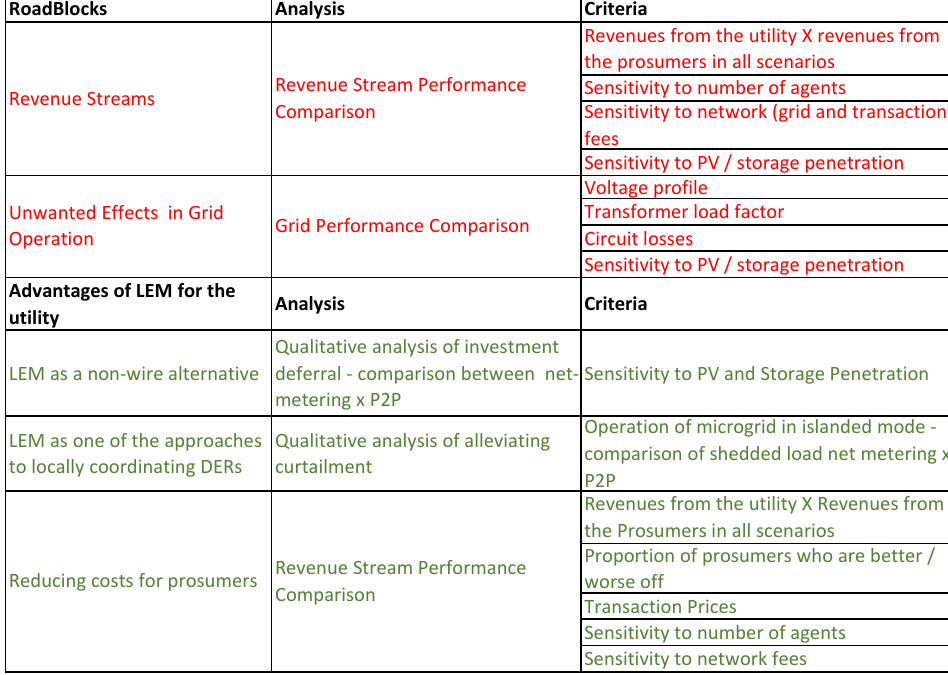
Figure 1. Evaluation framework for adoption of P2P markets by